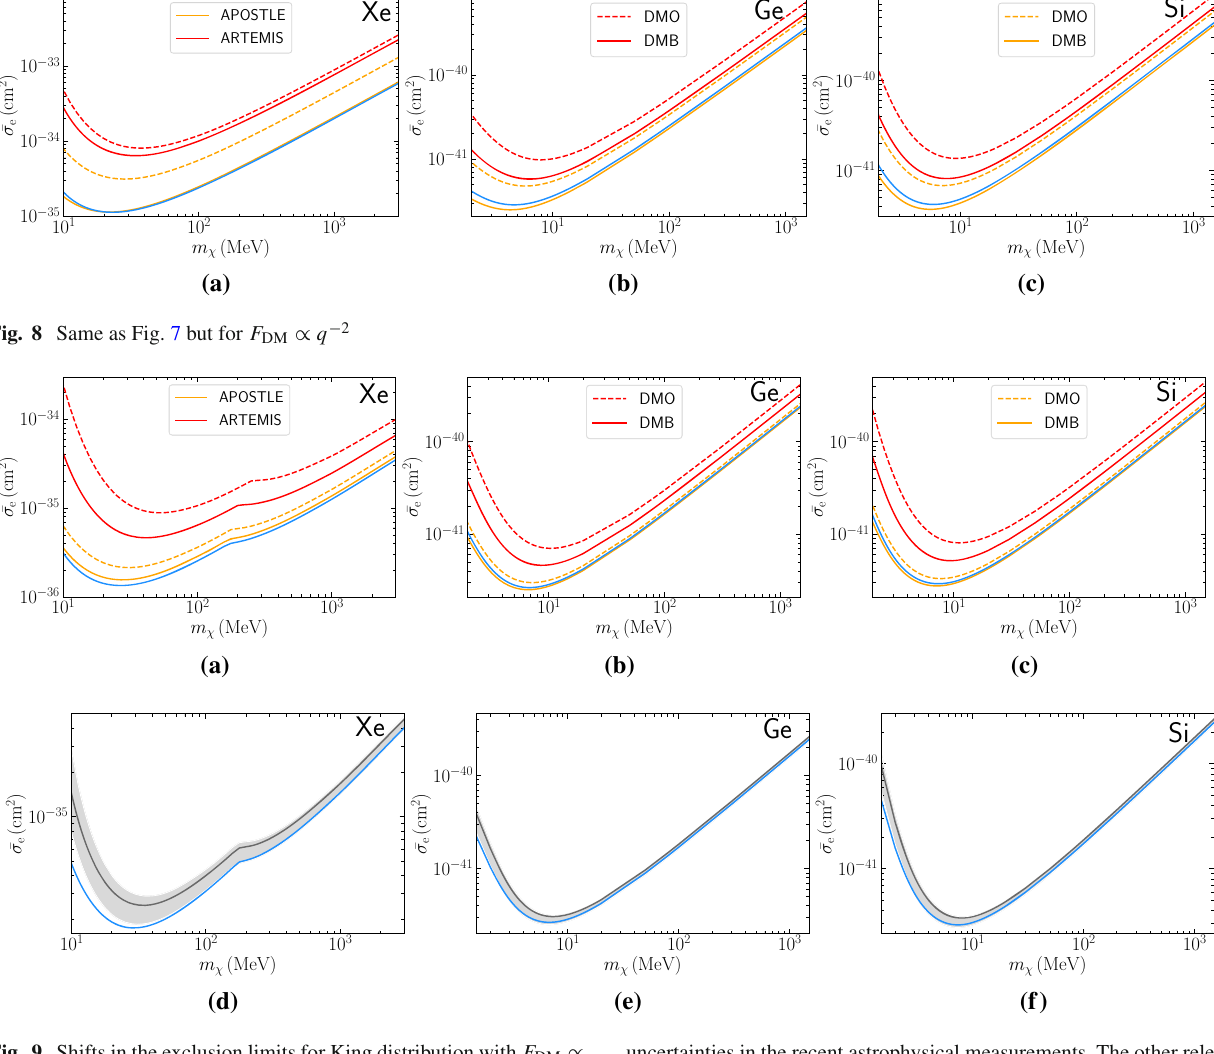
Fig. 9 Shifts in the exclusion limits for King distribution with F DM ∝ q − 1 . Upper panel shows the variations for the best fit values of differ- ent cosmological simulations. The bands in the lower panel represent